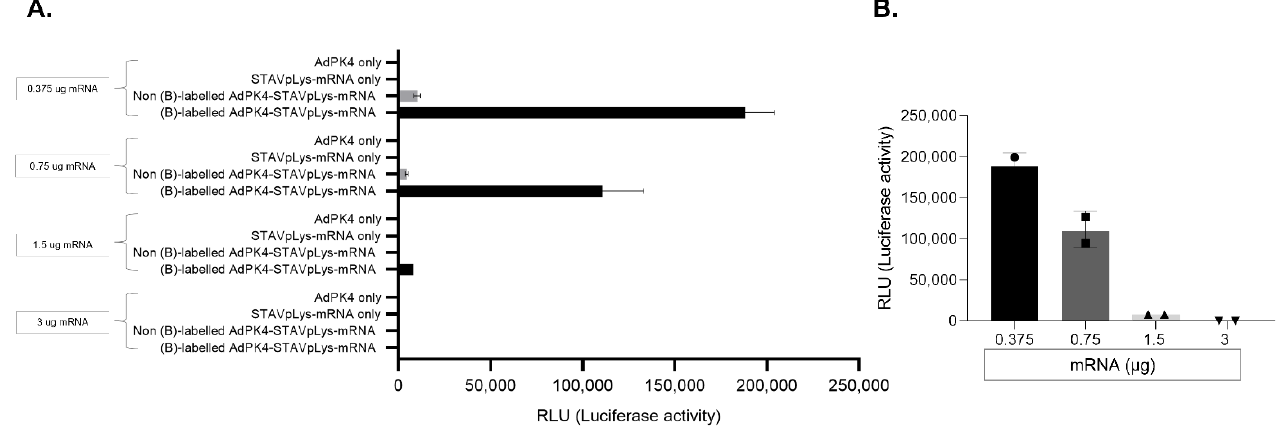
Figure 2. Evaluation of gene transfer efficiency mediated by AdPK4-STAVpLys-mRNA complexes. To evaluate mRNA gene transfer mediated by the AdpL vector, a fixed quantity of biotinylated virus (Figure S1) containing 800 ng StAV conjugated with 880 ng pLys was complexed with different amounts of mRNA (0.375, 0.75, 1.5, or 3 ug) and tested in CHO cells by measuring luciferase gene expression forty-eight hours after virus infection in parallel with controls Average of three technical replicates ( A ). Presentation of the dose-dependence of mRNA gene transfer efficiency. Average of two technical replicates ( B ).